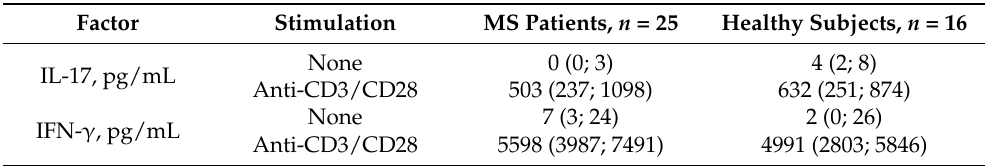
Table 1. The secretion of cytokines by CD4 + T cells (ELISA) in MS patients and in healthy subjects. Data are medians (25th and 75th percentiles).